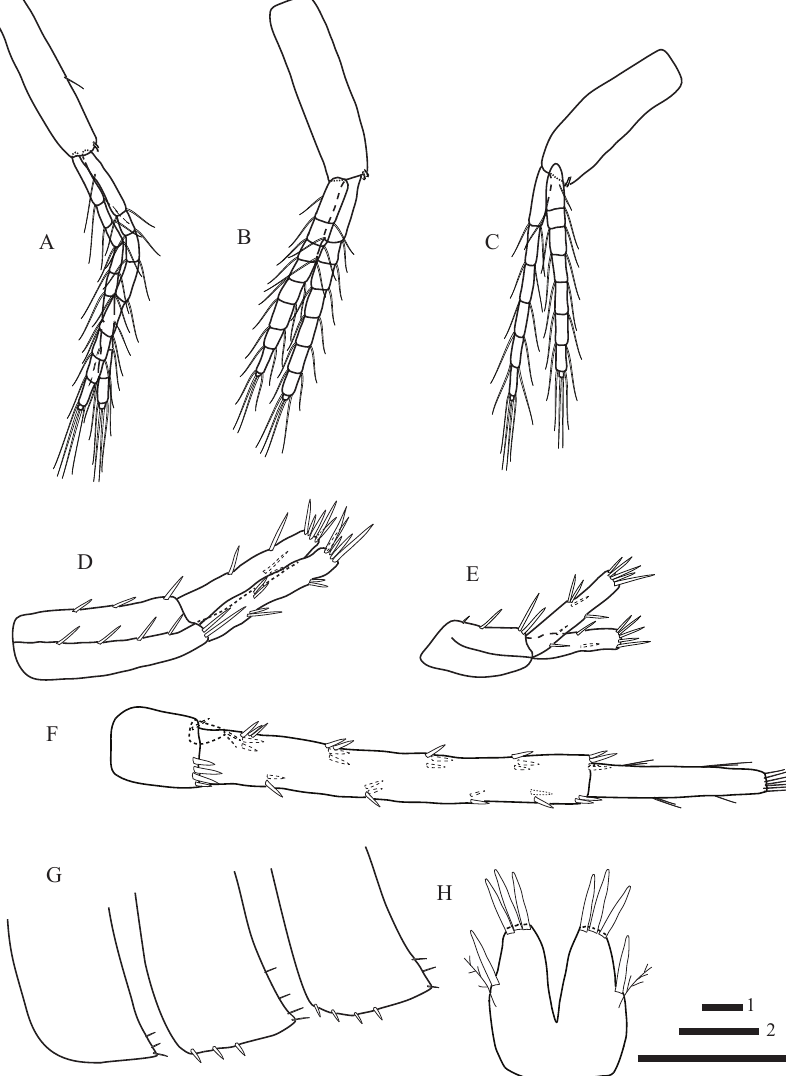
Figure 5. Niphargus hakani sp. n., male 9 mm (holotype, ZCRU Amph.1010). A Pleopod I B Pleo- pod II C Pleopod III D Uropod I E Uropod II F Uropod III. G Epimeral plates H Telson. Scale bars: 1=0.5 mm ( G–H ). 2=1 mm ( A–E ). 3=2mm F